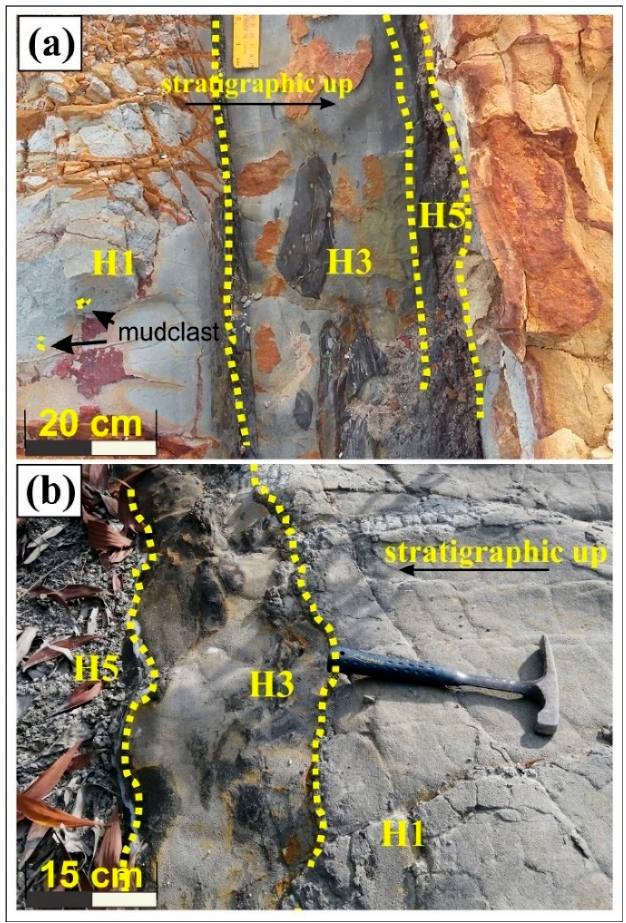
Figure 8. Variable expressions of hybrid event bed facies in frontal lobes. ( a ) Frontal area of the lobe near to the axis has brief hybrid event bed intervals mainly containing H1 and H3 facies with floating mud clasts in the Sepangger (SP) section, NW Sabah. ( b ) The frontal area away from the axial lobe domain has distinct muddy hybrid facies of H3 to H5 and the vertical thickness of the hybrid sequence also increases significantly in the Lapasan (LPS) section, NW